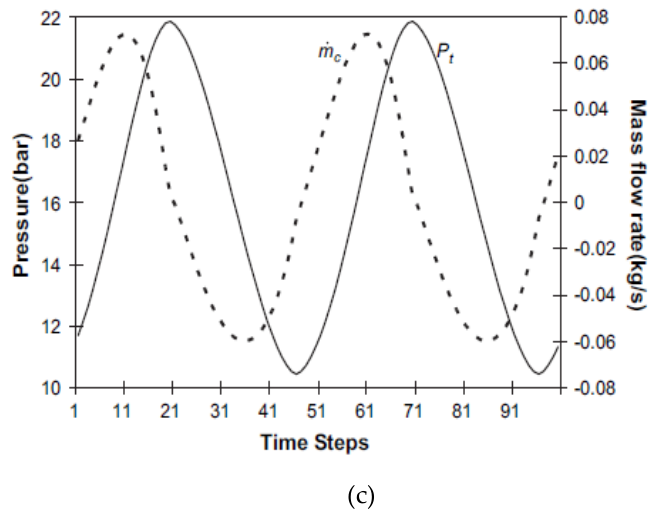
Figure 4. Phase relation e ff ect between pressure and mass flow rate: ( a ) Case 1; ( b ) case 2; ( c ) case 3.